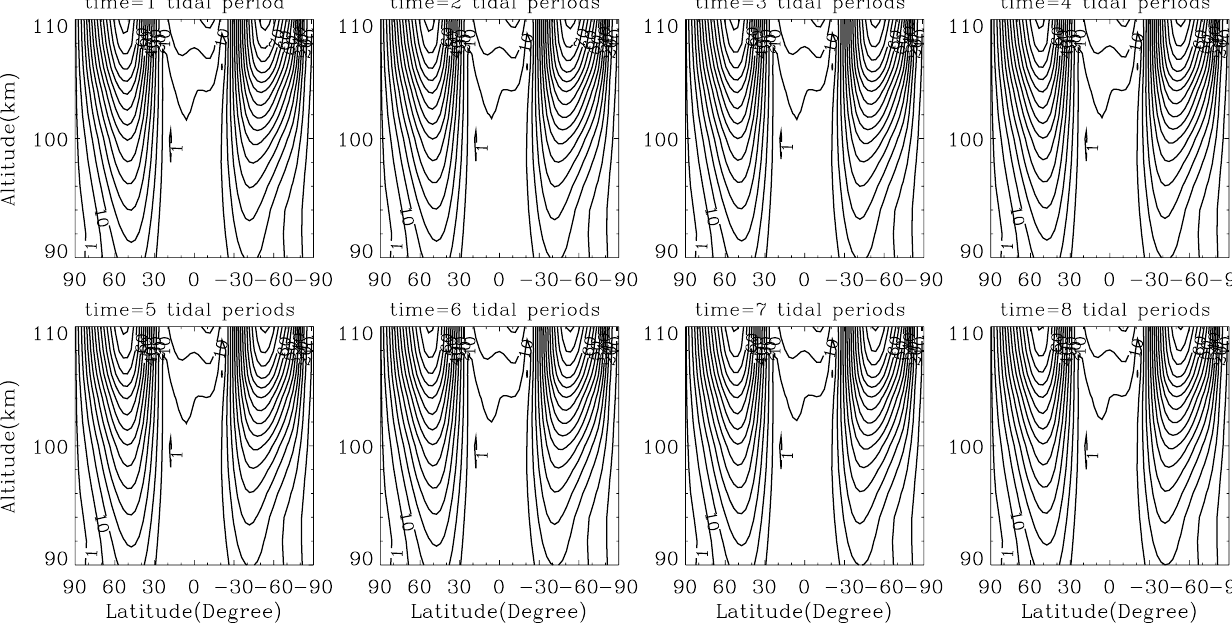
Fig. 1. Temporal evolution of the zonal-wind amplitudes within 8 tidal periods for March deduced from the linear propagation solution of the migrating semidiurnal tide starting from the GSWM-00 tidal oscillations. The minimum values of the contours are 1ms − 1 , and the intervals of the contours are 5ms − 1 when the amplitudes are greater than